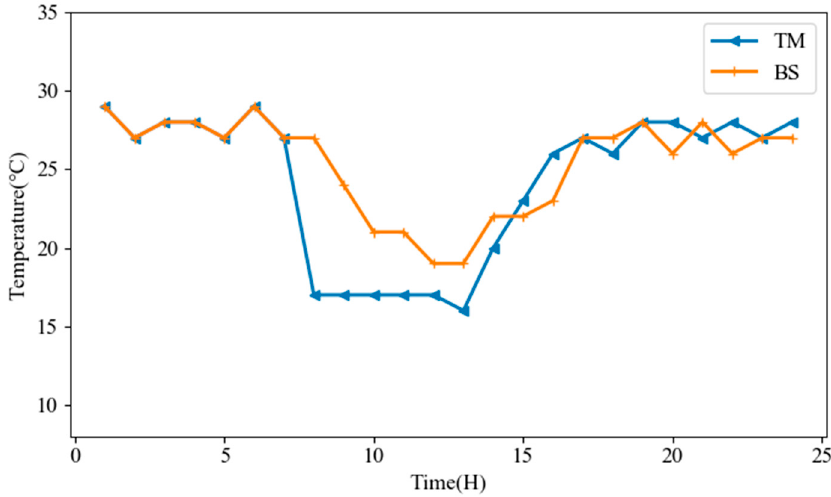
Figure 9. Supply air temperature variation provided by the cooling device.